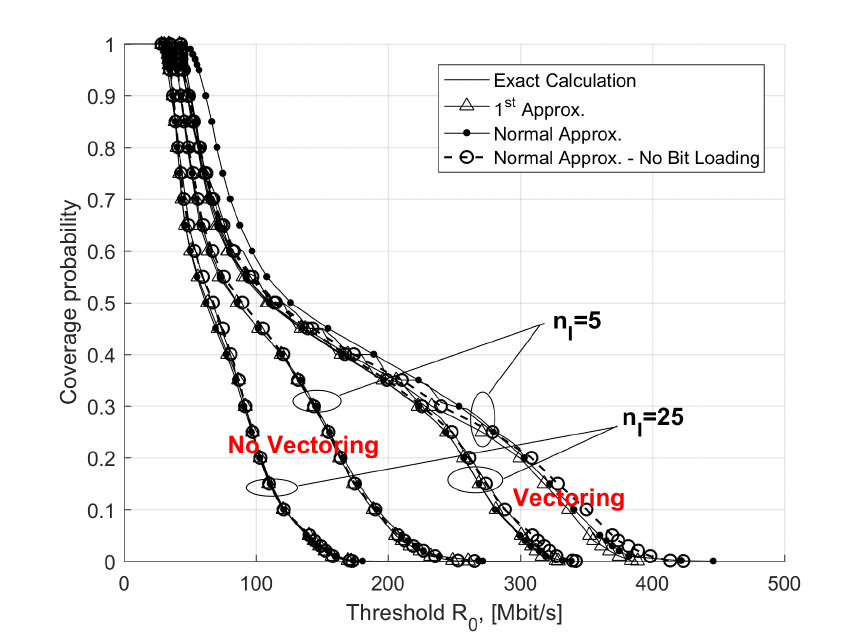
Figure 9. Exact and approximated bit rate coverage with and without